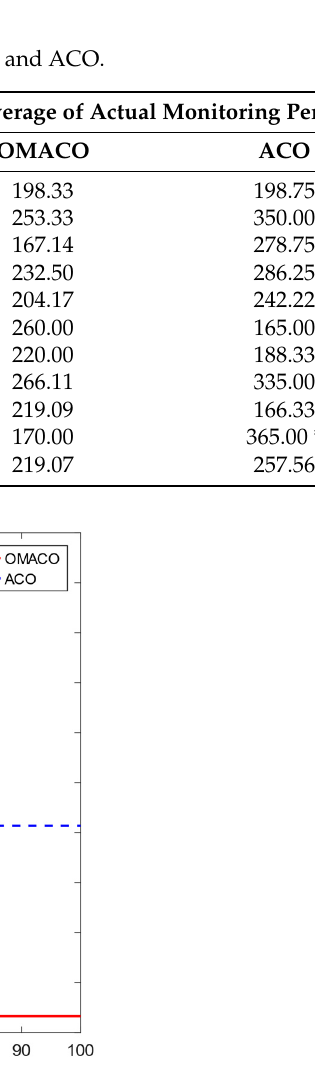
14 of 18 Table 3. Monitoring results comparison between OMACO and ACO. Node